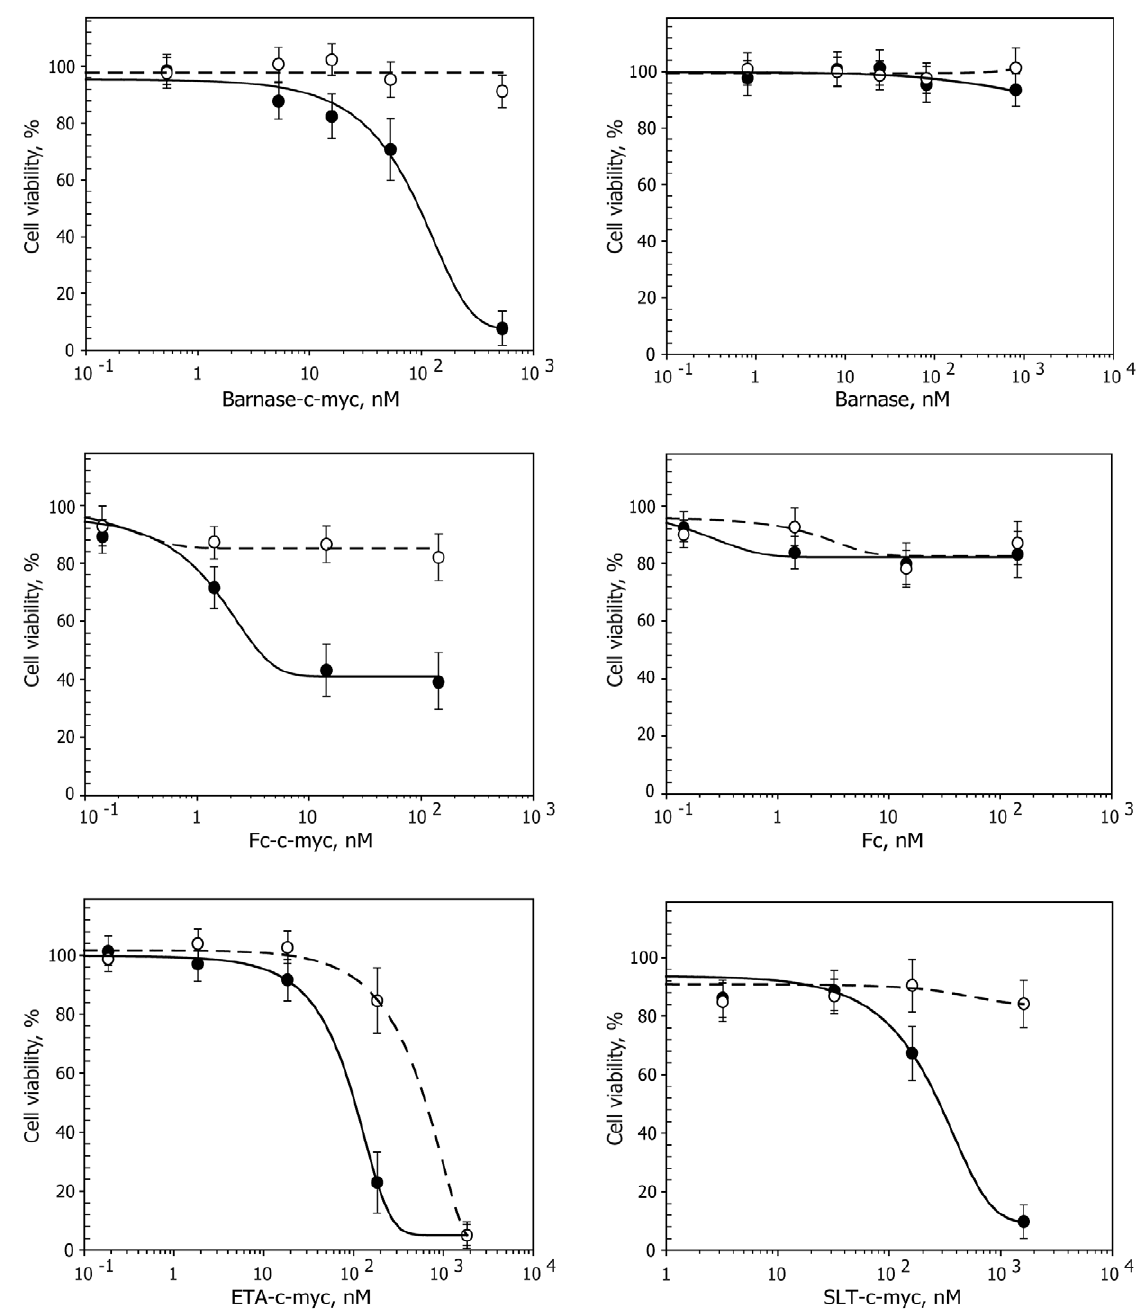
Figure 3. Functional activity and specificity of the obtained immunotoxins tested ex vivo. ITs’ activity was determined by the ex vivo elimination of the targeted C-MYC (solid line) and irrelevant (dotted line) hybridoma cell lines depending on the IT’ concentration. IT containing c- myc sequence selectively killed targeted hybridoma, keeping the irrelevant cells alive. Barnase-c-myc and Fc-c-myc showed rather high cytotoxicity and specificity. ETA-c-myc was highly cytotoxic for both cell lines. SLT-c-myc molecule showed intermediate level of the cytotoxicity and specificity. Bars represent standard deviation (n=3).